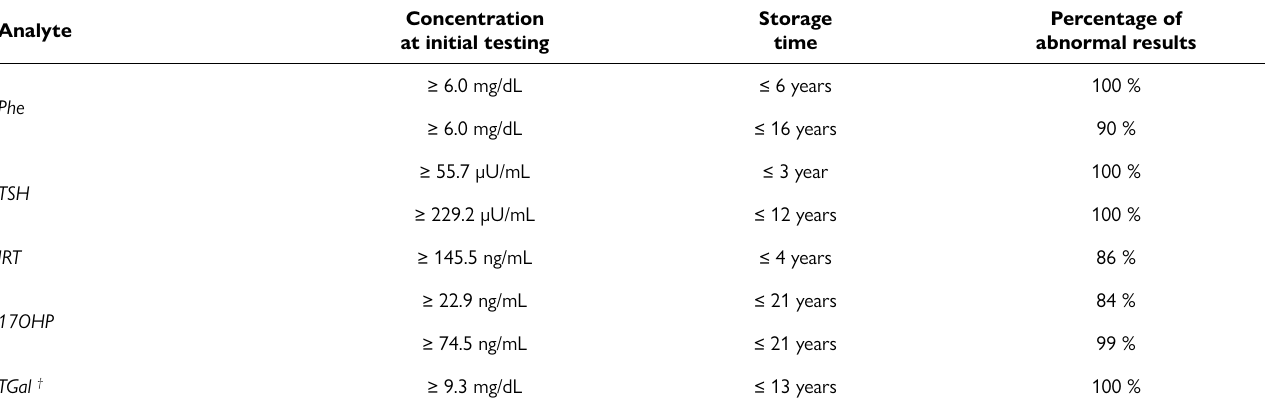
Table 4. Percentage of abnormal results at retesting found at different analytes concentrations and storage periods. Analyte